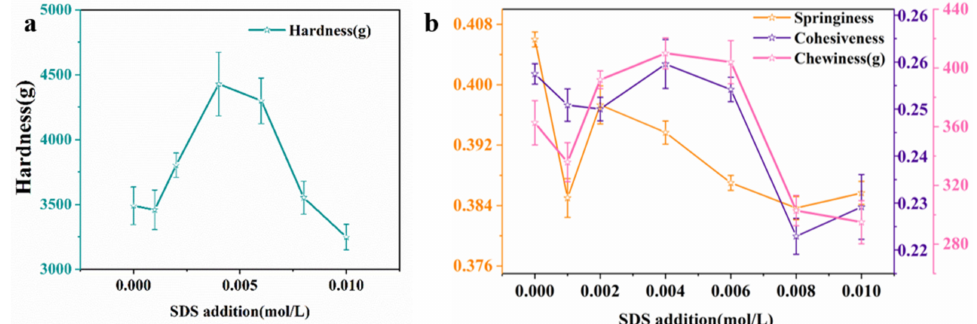
Figure 4. TPA parameters of hardness of composite hydrogel with different sodium dodecyl sulfate (SDS) concentrations ( a ); springiness, cohesiveness and chewiness of composite gel with different SDS concentrations ( b ).